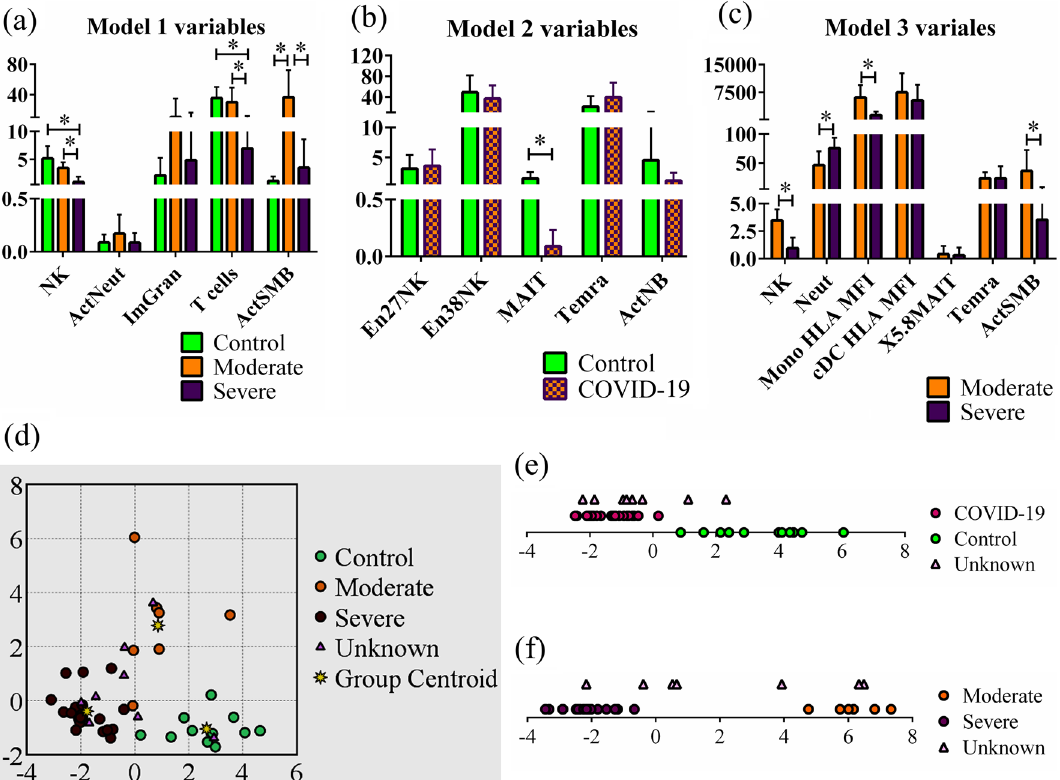
Figure 1. Discriminant analysis-based distinction between COVID-19 patients presenting with different levels of disease severity and healthy volunteers. Discriminant analysis was done using the stepwise method and raw data corresponding to the variables entered in models 1, 2, and 3 are shown in ( a–c ), respectively. ( d ) Model 1: distinction between healthy volunteers (n = 11), moderately ill (n = 7), and severely ill (n = 20) COVID-19 patients. ( e ) Model 2: distinction between healthy volunteers (n = 11) and COVID-19 patients including moderately and severely (n = 27) ill patients combined in one group. ( f ) Model 3: distinction between moderately (n = 7) and severely ill patients (n = 20). Graphs in ( e,f ) are drawn on 1 axis (i.e., the x-axis) and vertical elevation of data points is for illustration purposes only. NK natural killer cells, neut neutrophils, actNeut activated HLA-DR + neutrophils, imGran Ki67 + immature granulocytes, Mono HLA MFI MFI of HLA-DR in monocytes, MFI of HLA-DR in conventional dendritic cells, MAIT mucosal associated invariant T cells, CXCR5 + CD8 + MAIT CXCR5 + CD8 + mucosal associated invariant T cells, Temra CD27 − CD45RA +